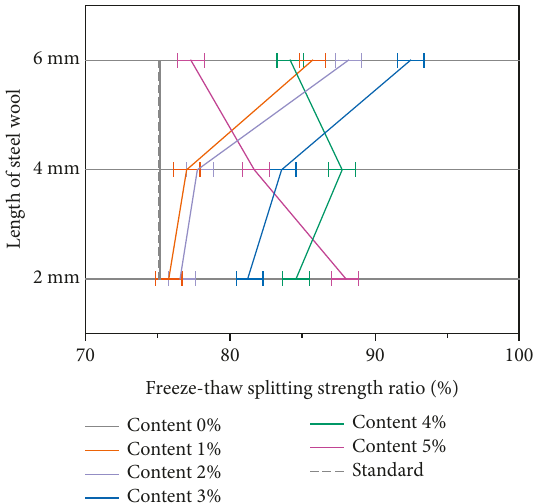
Figure 4: Water stability performance of steel wool asphalt